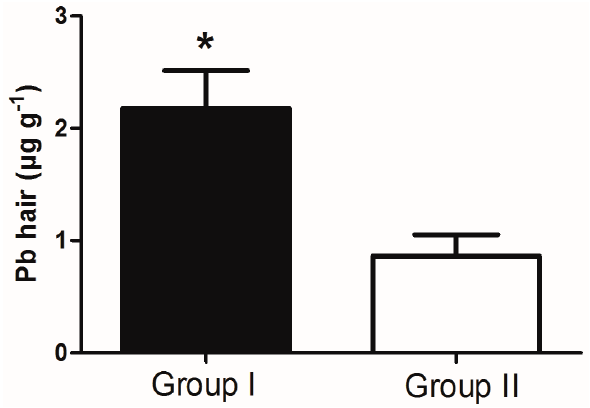
Figure 2. Rural children were divided into two groups according to different results in the Bender Test and significant differences between concentrations of Pb in hair: Group I—children with visual-motor immaturity ( n = 5) and Group II—children without visual-motor immaturity ( n = 6); * p < 0.01.